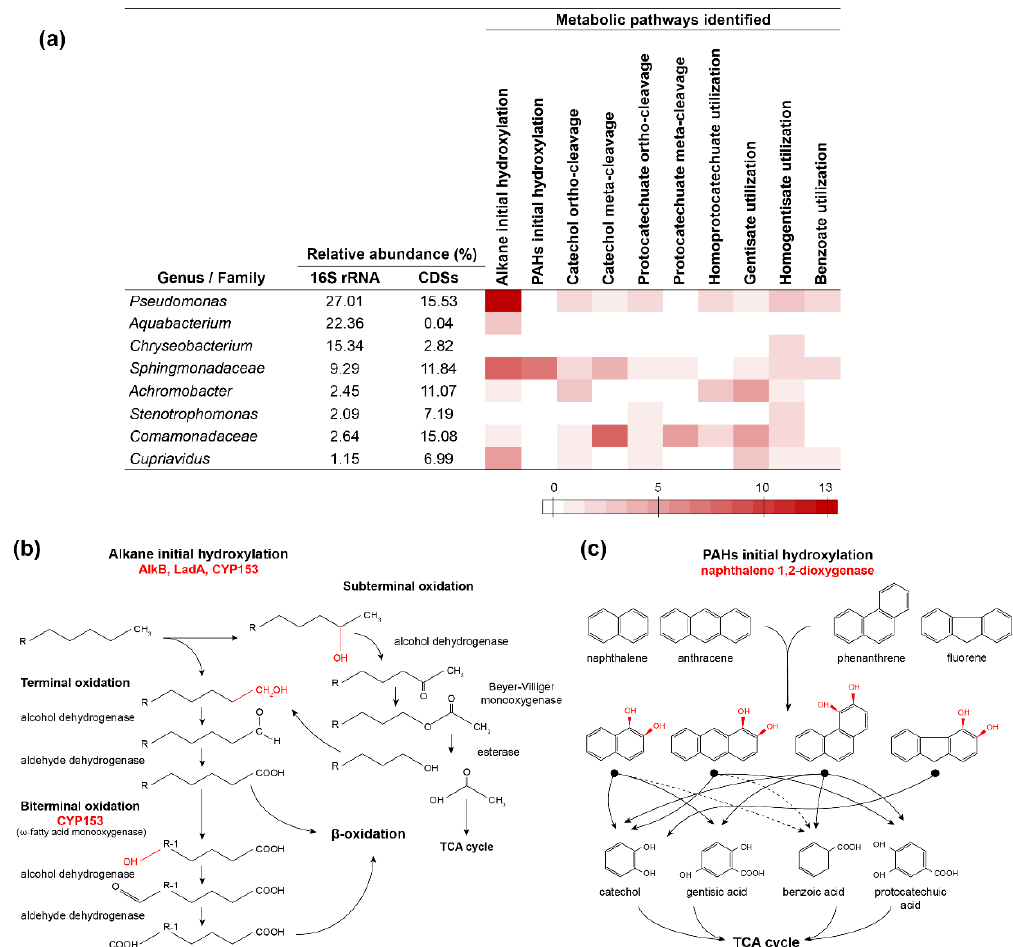
Figure 4. ( a ) Summary of alkanes, PAHs, and central aromatic biodegradation pathways found in the most abundant genera / families within the metagenome of the diesel-degrading consortium. Red scale bar represents the number of enzymes for each pathway identified. ( b ) Schematic view of the initial terminal, subterminal, and biterminal alkane aerobic oxidation mediated by AlkB, LadA, and CYP153 enzymes. Adapted from [7,8]. ( c ) Schematic view of initial naphthalene 1,2-dioxygenase hydroxylating reactions in PAHs components of diesel and aromatic central metabolites generated by further oxidation reactions of these cis -diol intermediates. Dotted lines indicate metabolic products depending on specific degradation pathways. Enzymes and chemical reactions catalyzed by these enzymes are indicated in red